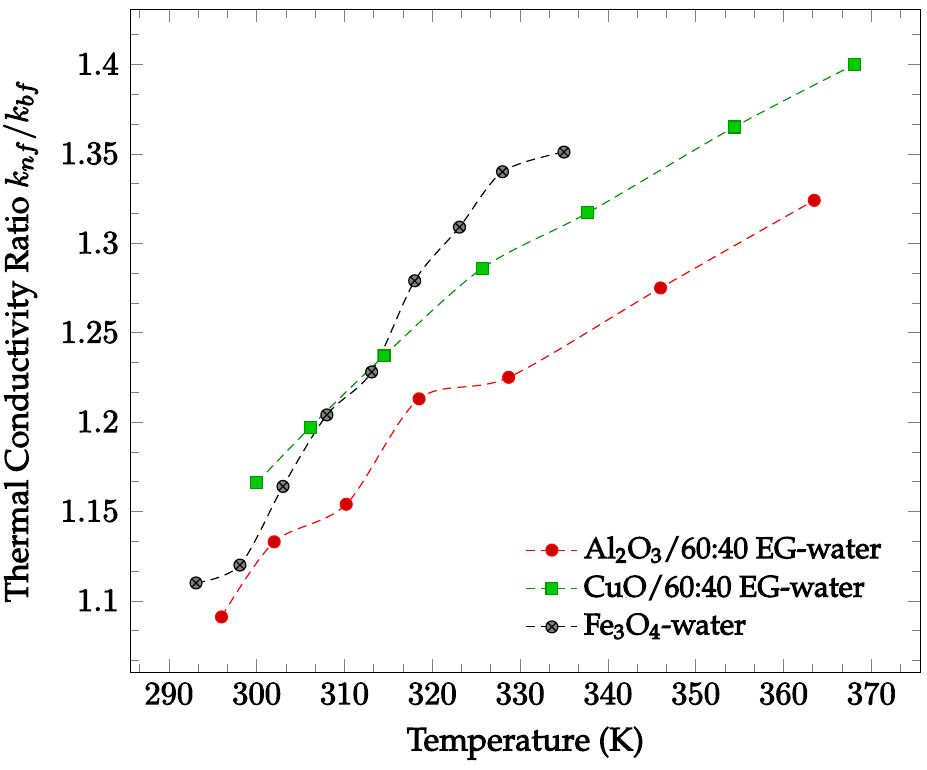
Figure 1. Dimensionless nanofluid thermal conductivity as a function of temperature for different nanofluids at 2% volume concentration, including Al 2 O 3 in 60–40% ethylene glycol-water [14], CuO in 60–40% ethylene glycol-water [14], and Fe 3 O 4 in water [15]. The enhancement of thermal conductivity in nanofluids is also a function of the concentration of nanoparticles. Increasing the volume fraction of nanoparticles tends to increase the thermal conductivity of a fluid. This is likely due to the increased number of collisions and therefore increased random particle motion present in the fluid. Figure 2 below shows thermal conductivity enhancement in CuO and Al 2 O 3 nanoparticles within water and ethylene-glycol as a function of volume fraction. In all four cases, the thermal conductivity enhancement increases along with nanoparticle concentration. The increase in thermal conductivity with increased concentration may be due to the increase in Brownian motion and particle interactions. The amount of random particle motion is higher due to a greater number of particles in a given volume of fluid. Additionally, as the concentration increases, the likelihood of particle collision increases, enhancing the average rate of energy transfer and thus improving the thermal conductivity of the nanofluid. It can be seen in most samples observed that the greatest rate of thermal conductivity enhancement occurs at lower concentrations. The decrease in the rate of thermal conductivity enhancement may be caused by the tendency of the nanoparticles to agglomerate at higher concentrations. The agglomerates are much larger than the nanoparticles, reducing the effectiveness of the thermal conductivity enhancement. However, the increase in particle concentration still leads to overall thermal conductivity enhancement. As such, the rate of thermal conductivity enhancement is generally highest for lower volume